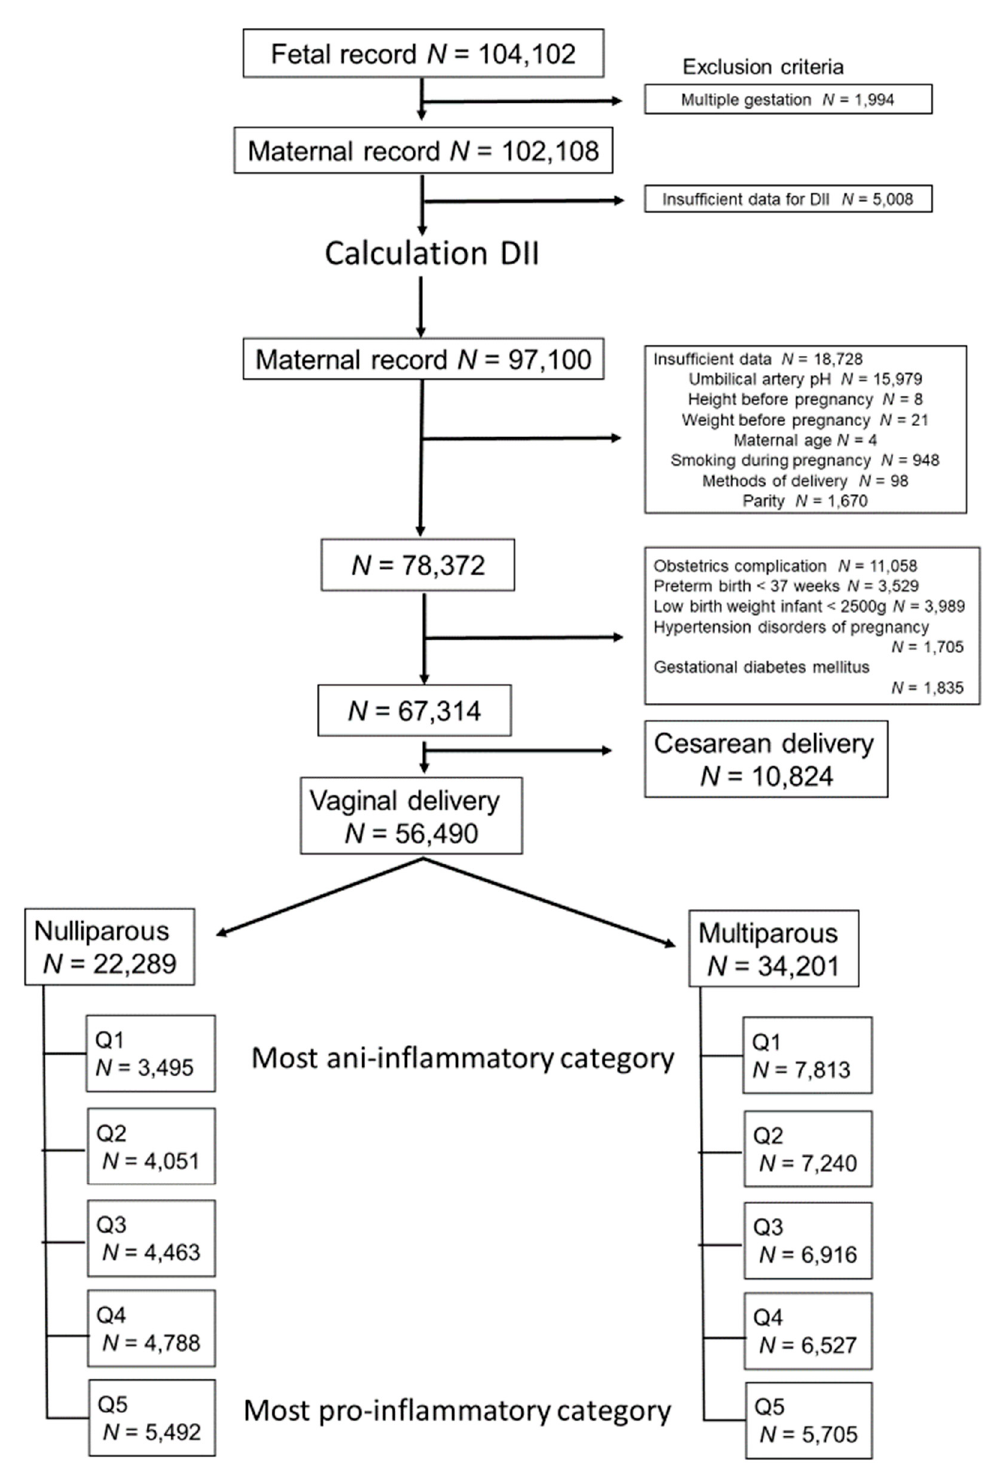
Figure 1. Study inclusion and exclusion criteria. DII: dietary inflammatory index.